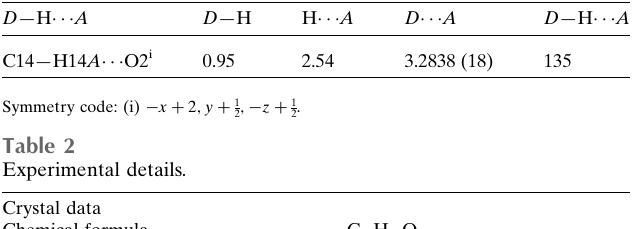
Figure 1 The molecular structure of I showing displacement ellipsoids at the 50% probability